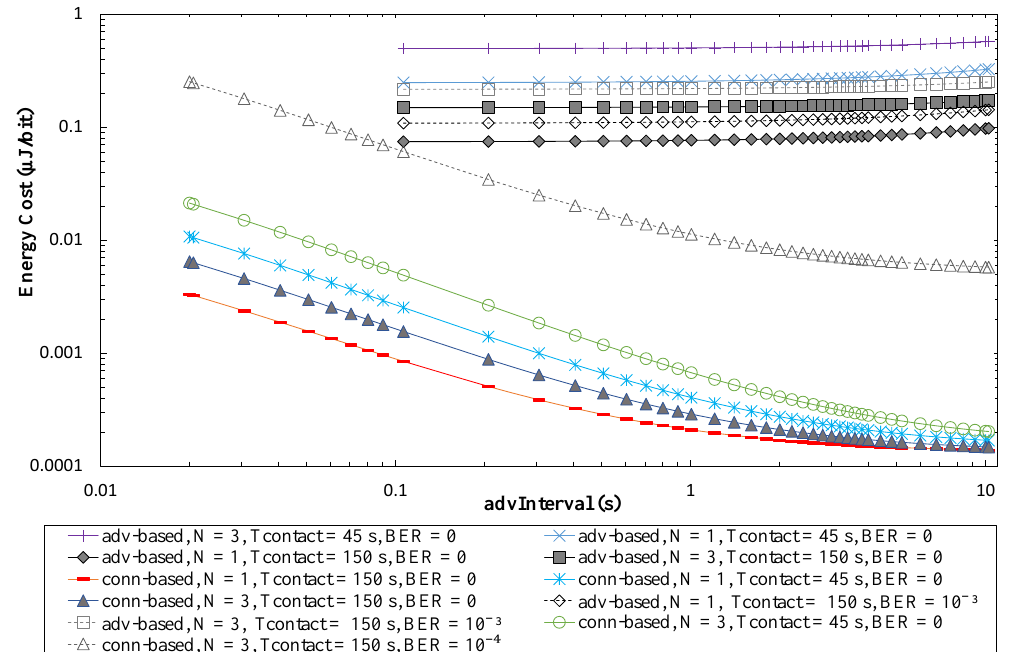
Figure 22. Energy cost for the advertisement-based and the connection-based approaches as a function of advInterval , for different T contact and N values, assuming connInterval = 4 s, and a time between contacts of one day.